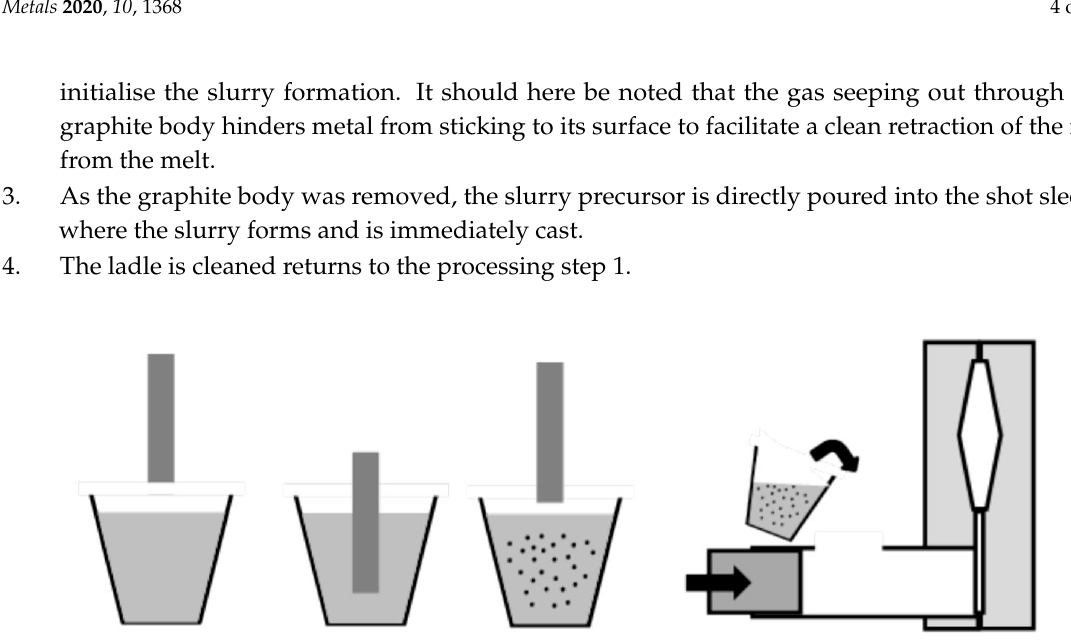
Figure 1. The Gas-Induced Superheated-Slurry (GISS) process (courtesy GISSCO).